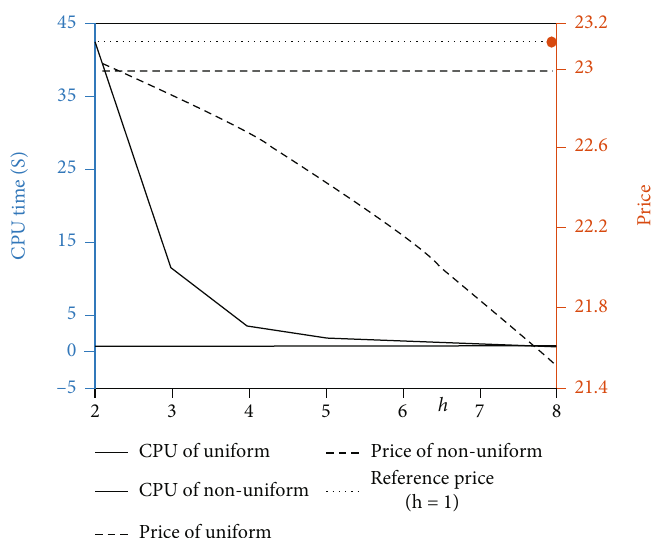
= 1, m = 2 , and m = 3, m = 1 and 1 2 3 4